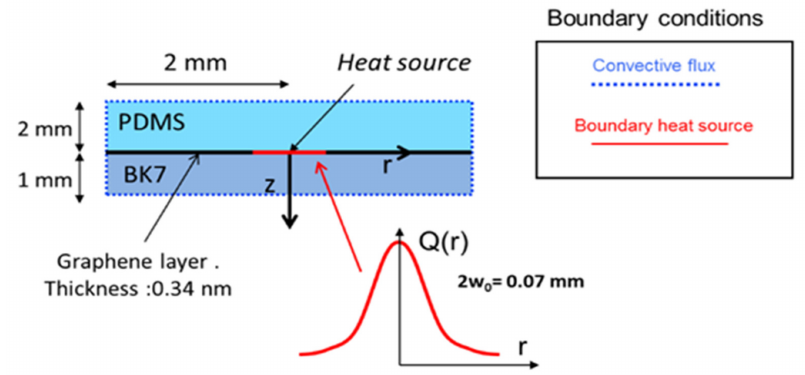
Figure 2. Geometry of the thermo-optical model, completed with the boundary conditions used in the COMSOL code. The convective parameter is h = 10 W/m 2 K.